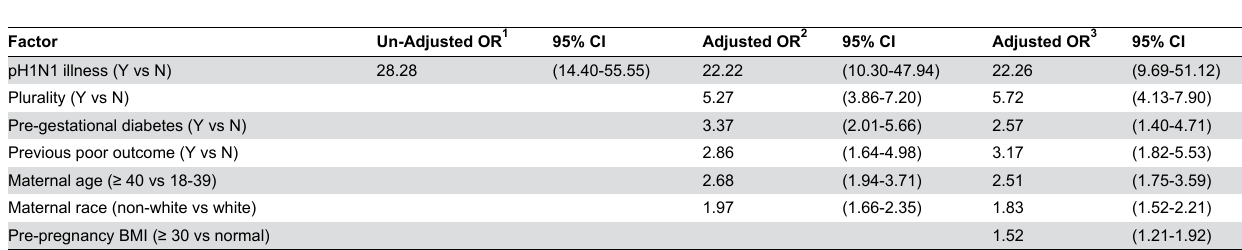
Table 5. Factors associated with maternal admission to Intensive Care Unit